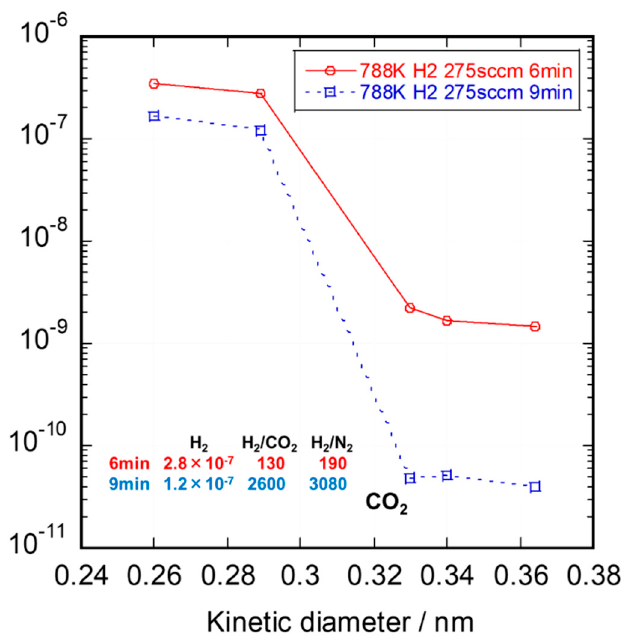
Figure 10. Deposition time dependence on single gas permeance of SiC membranes.